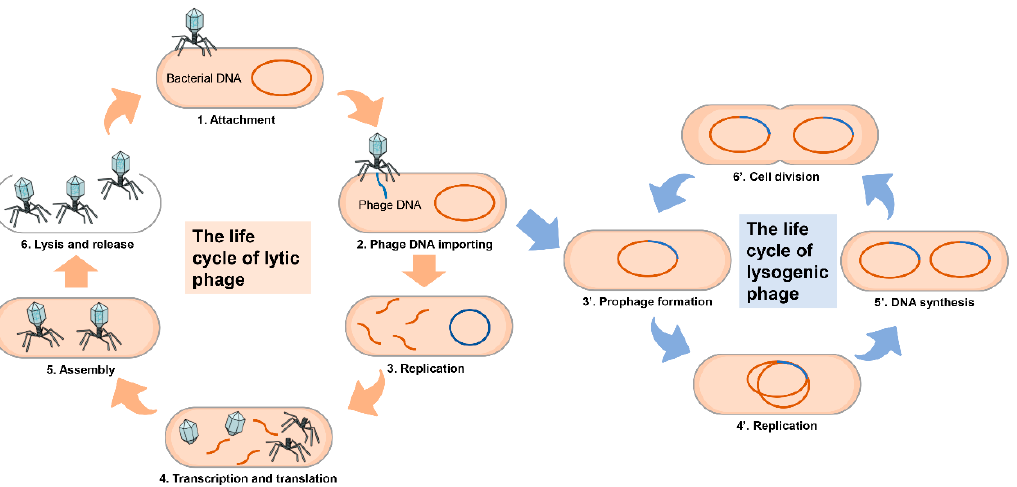
Figure 1. The life cycle of a phage can be cellular or lysogenic. The lytic cycle comprises: (1) the attachment of phage to the receptors on the cell membrane of host bacteria, (2) the import of its genome, (3) replication in the interior of the host cell, (4) subsequent transcription and translation, (5) assembly and (6) the release of phage progeny. Lysogenic phages enter the (3’) stage, are integrated into the bacterial chromosome and then start to replicate with the host cell.